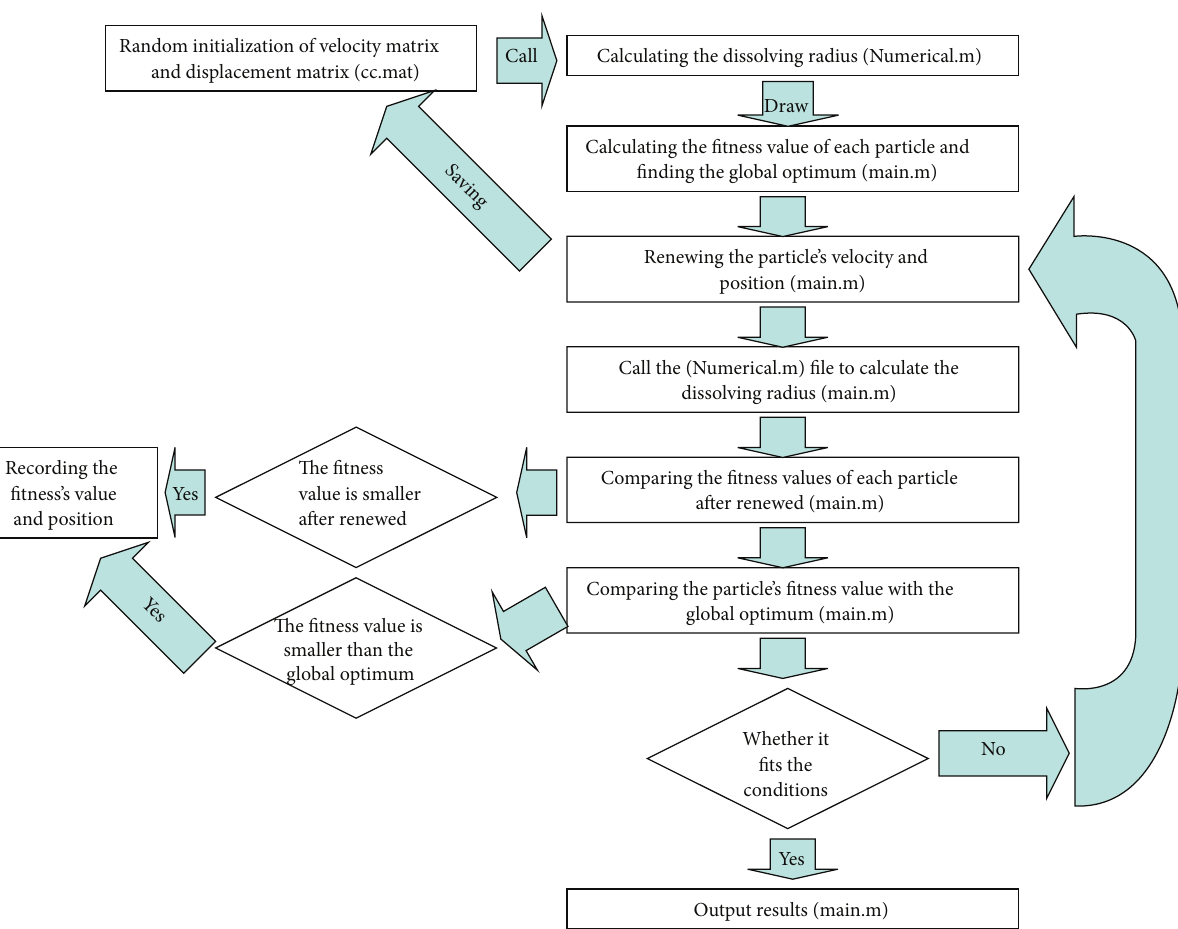
Figure 7: Flow chart for program